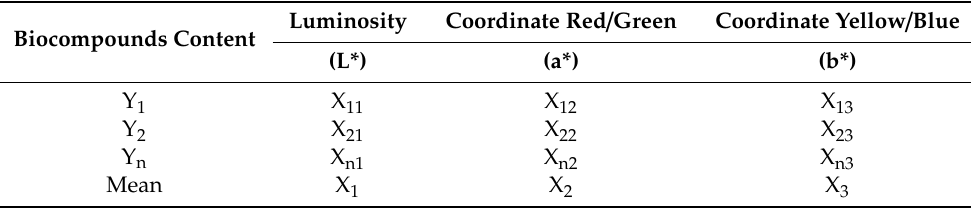
Table 1. Multivariate components